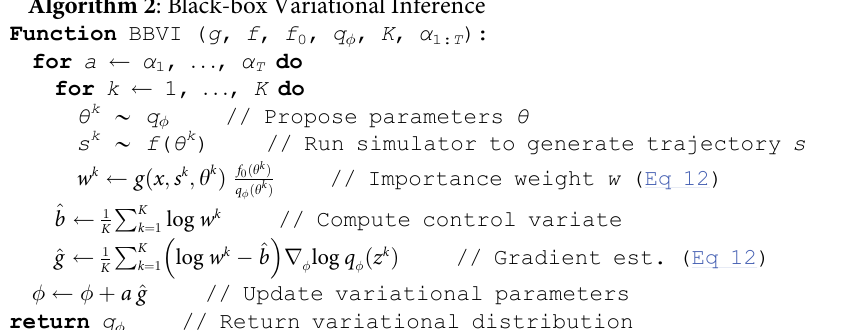
Algorithm 2 : Black-box Variational